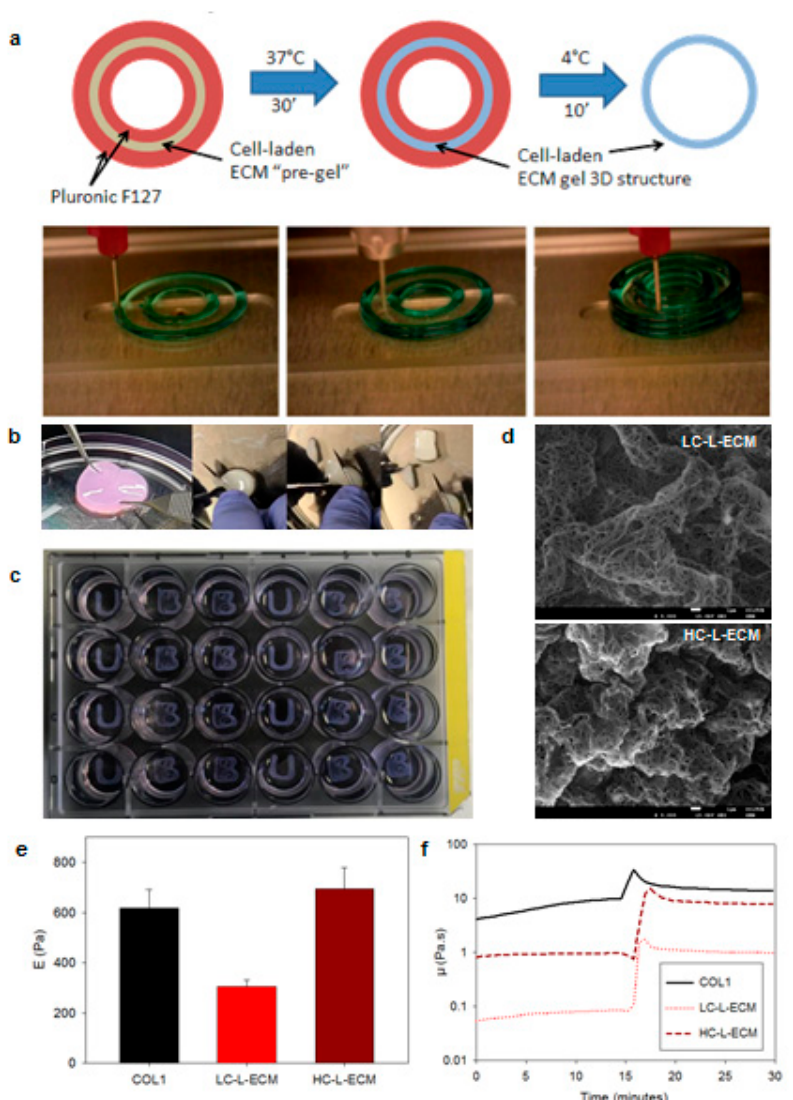
Figure 1. Fabrication and characterization of the lung extracellular matrix (L-ECM) scaffolds. ( a ) Scheme and photo- graphs of the bioprinting process using F-127 as a sacrificial layer. L-ECM was printed in liquid phase. After gelification of the cell-laden hydrogel, the pluronic structure was dissolved. ( b ) Macroscopic images of the high concentration (HC)-L-ECM structures showing structural integrity allowing manipulation with tweezers and to be cut with a scalpel. ( c ) Scaffolds 3D-bioprinted in multiple shapes in a standard p24 well-plate. ( d ) Representative scanning electron microscope (SEM) images of the low (left) and high (right) concentration lung hydrogels ultrastructure. Scale bar =1 µm ( e ) Quanti- fication of the apparent Young’s modulus of the different hydrogels with the atomic force microscope. ( f ) Viscosity ( µ ) of the different hydrogels when temperature was varied from 4 °C to 37 °C, at time 15 min, measured by